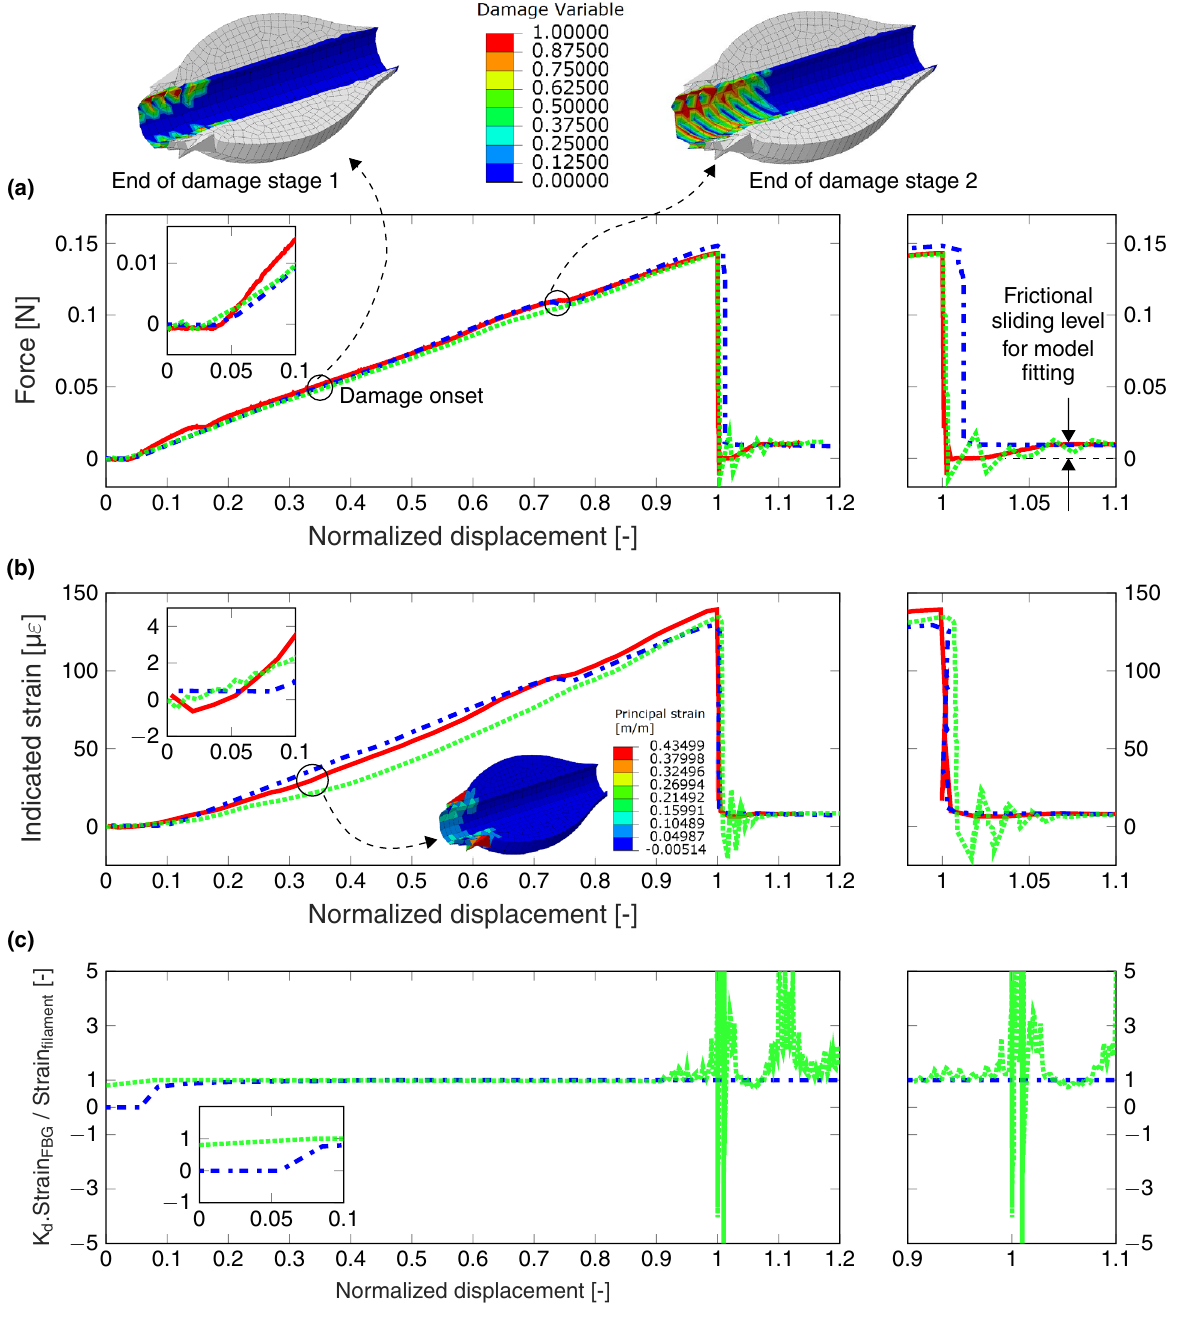
Figure 7. Different output results from FEA and experimentation: ( a ) the force as a function of test progress; ( b ) the strain (FBG) as a function of test progress; and ( c ) the ratio of FBG strain to filament strain based on FEA; test progress given by normalized blade displacement. K d = 32.79 (glass filament). The experimental force data has sampling rate of 1 kHz and the strain data 50 Hz. [FE insets for ( a ) and ( b ) are generated using Abaqus Standard/Explicit software, version 2017, https:// www. 3ds. com/ produ cts- servi ces/ simul ia/ produ cts/ abaqus/, the graphical plots are generated using latex-pgf plot